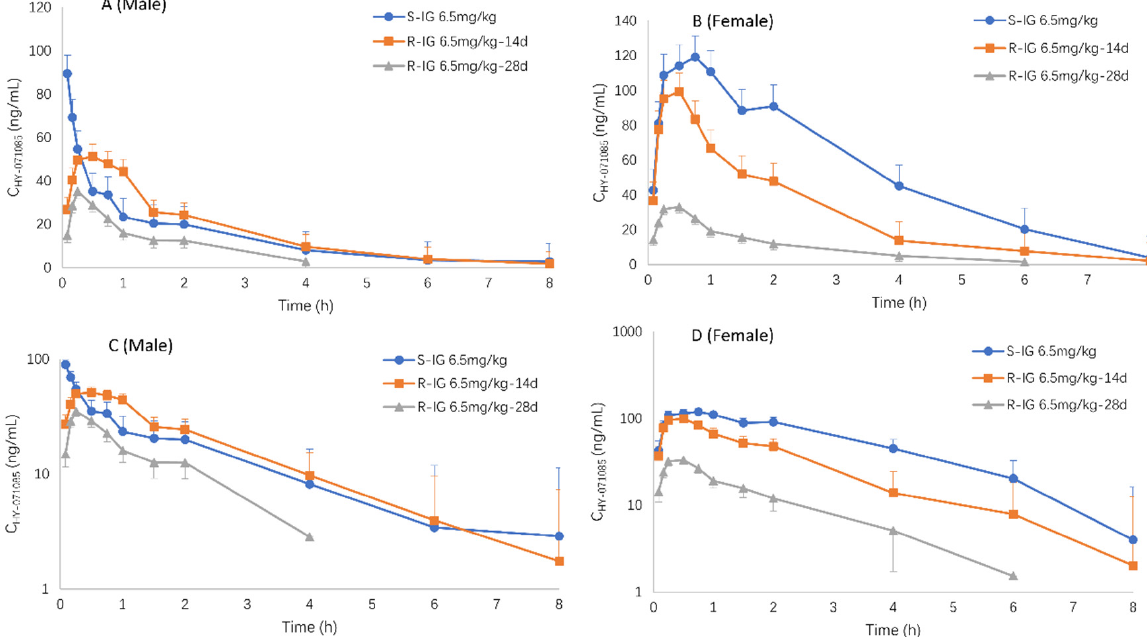
Figure 5. Mean plasma concentration–time curves of HY-071085 after repeated intragastric doses of 6.5 mg/kg in rats. ( A ) Constant coordinates; ( B ) semilogarithmic coordinates.